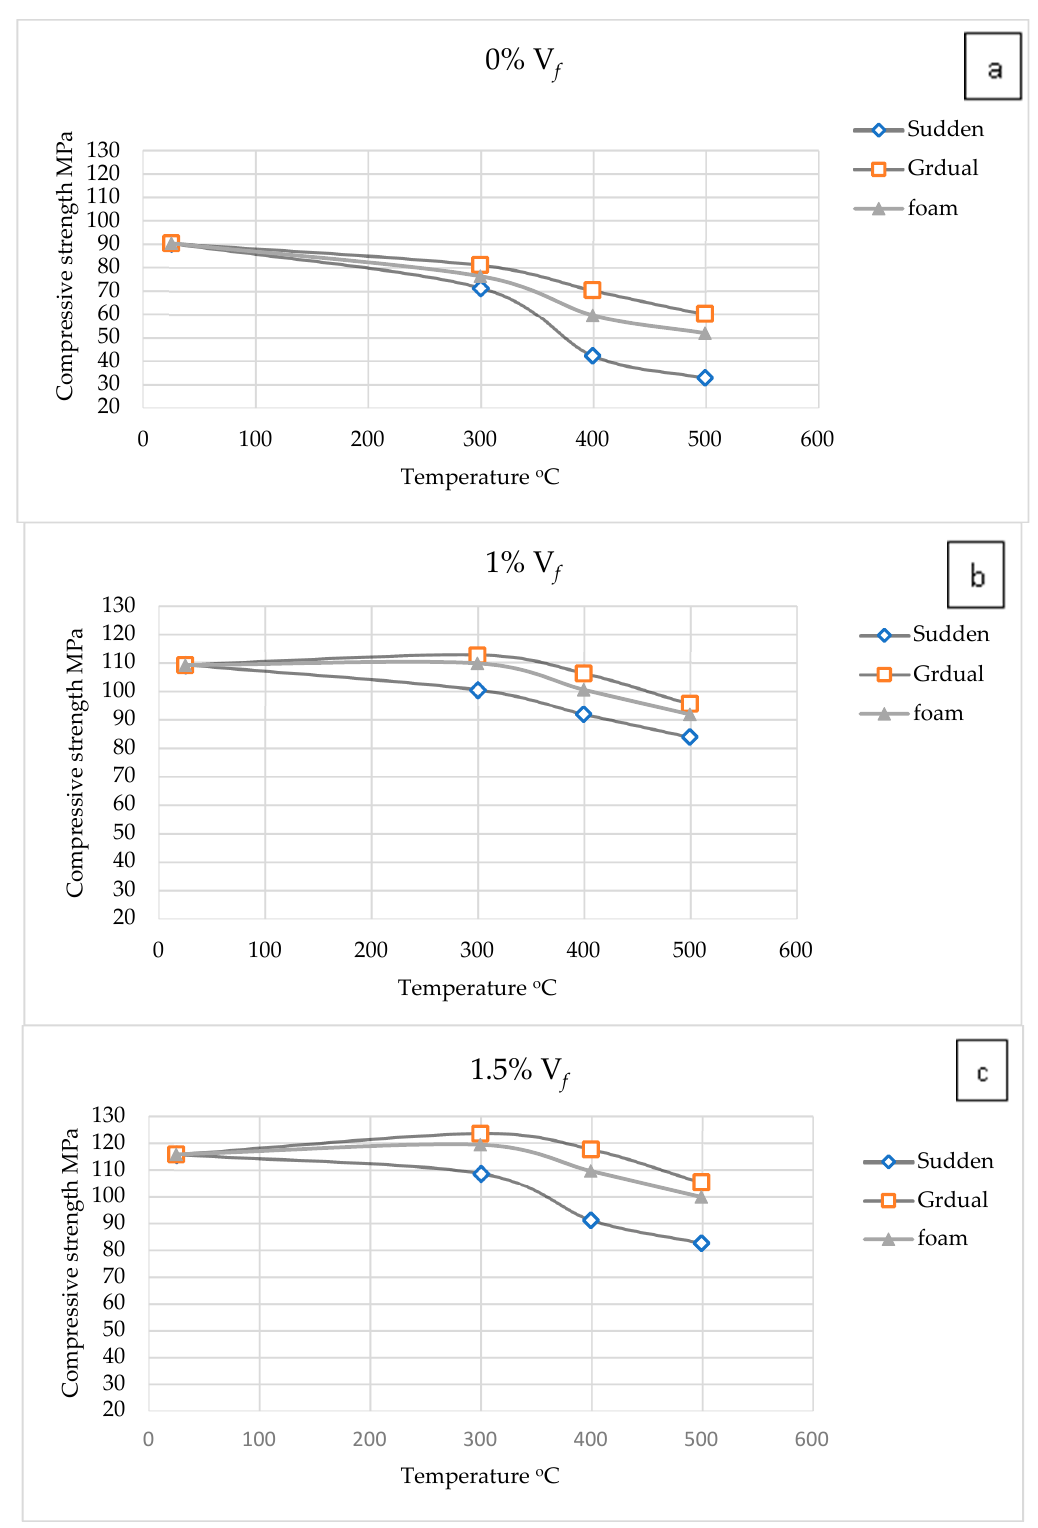
Figure 4. Compressive strength concerning all burning temperature and cooling methods: ( a ) For 0% V f ; ( b ) For 1.0% V f ; and ( c ) For 1.5% V f .